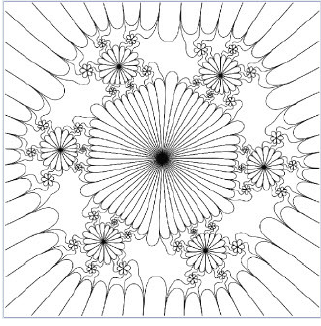
Figure 18. A coloring page from Barnes et al. [51] available on https://www.maa.org/press/ periodicals/math-horizons/math-horizons-supplements (accessed on 20 October 2021).